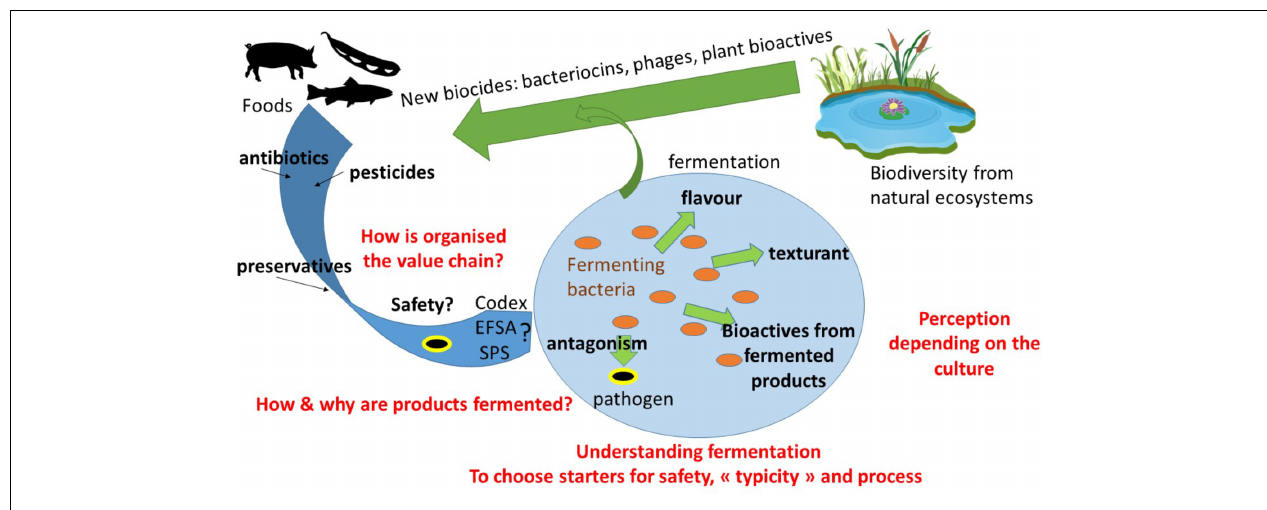
FIGURE 1 | Prospects for food fermentation in South-East Asia with the approach from the Tropical Fermentation and Biotechnology Network.